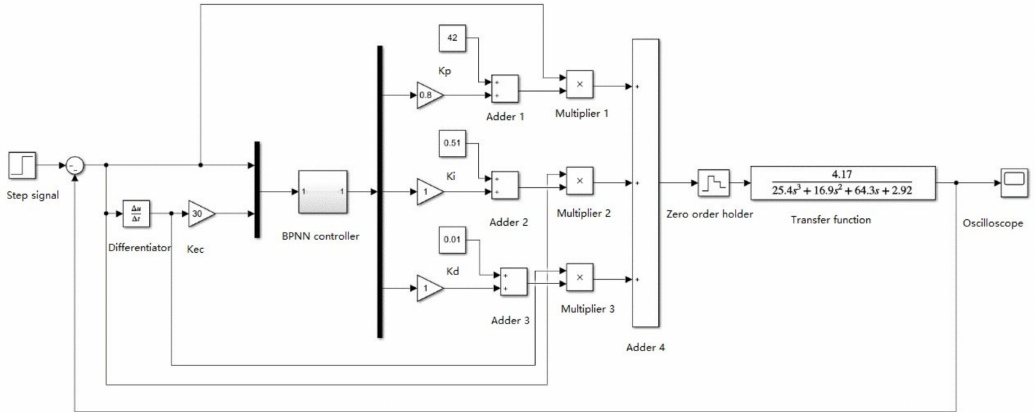
Figure 12. BPNN–PID control system